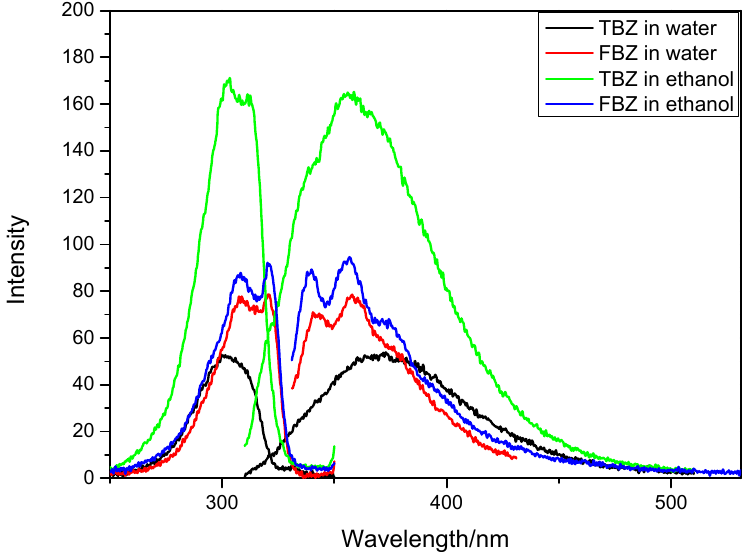
Figure 1. Excitation and emission fluorescence spectra of thiabendazole (TBZ) (300 ng/mL) and fuberidazole (FBZ) (30 ng/mL) in water and ethanol.